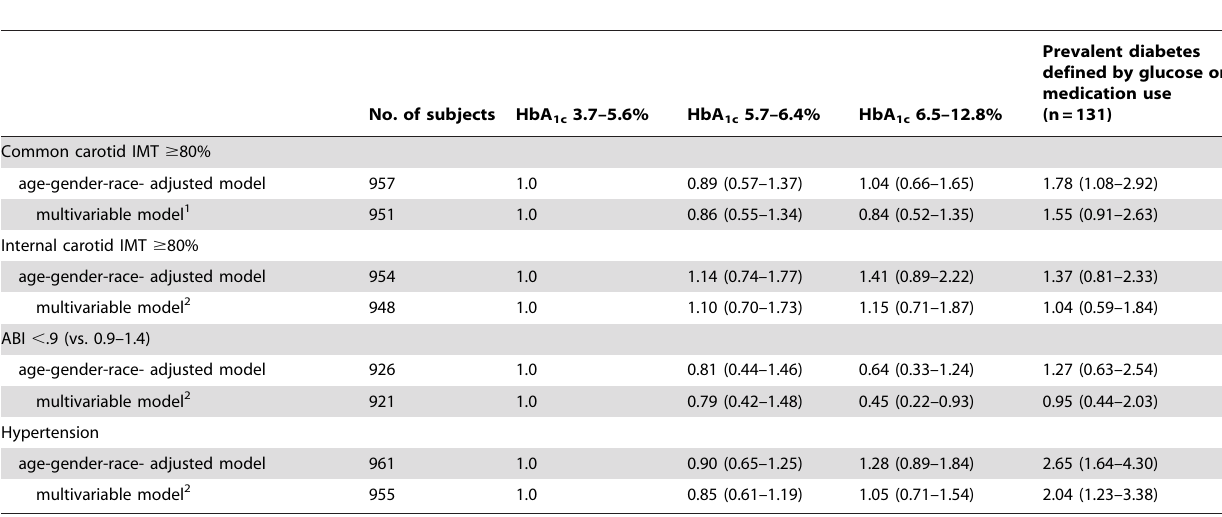
Table 3. Odds ratios and 95% confidence intervals for selected measures of stiffness/atherosclerosis, according to categories of HbA1c and prevalent